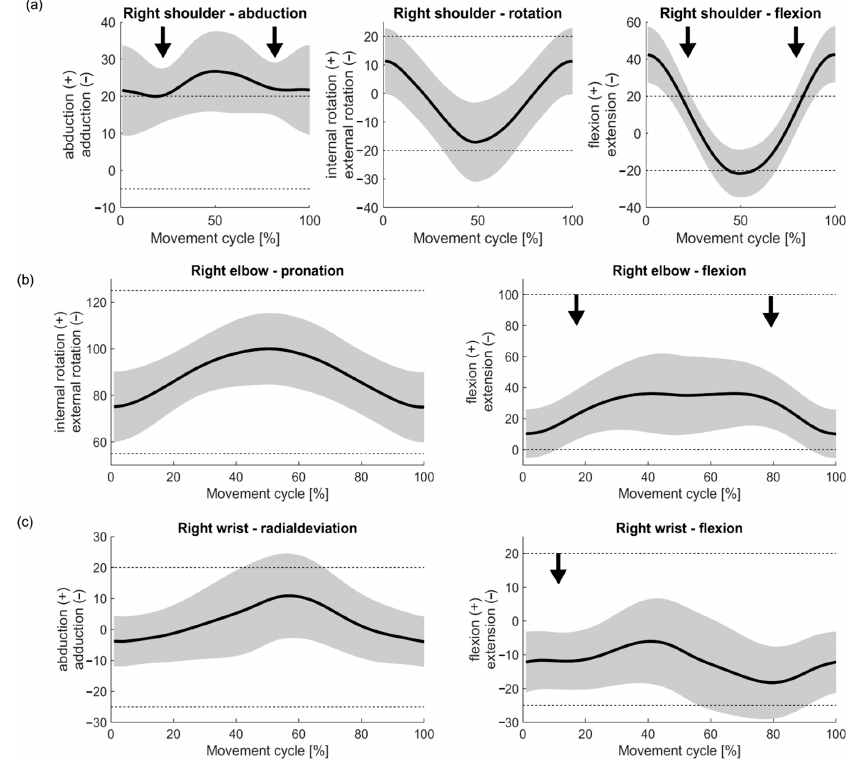
Figure 4. Movements of the right shoulder ( a ), elbow ( b ) and wrist ( c ) in the habitual vacuuming cycle (mean—solid line and standard deviation—grey area). The time dependent angles were time normalized to a full movement cycle. The dashed lines are the lower and upper limits for neutral movements. Movements within the neutral zone are considered ergonomically [21] . The black arrows point to time points of minimal standard deviation. Table 2. Mean values and standard deviations of movements of the right shoulder, elbow and wrist over the course of the cycle. Mean ± SD at Mean ± SD at Cycle Mean of SD Mid-Cycle Start/End (Distal ± SD (Over Joints Dimensions (Proximal Turning Point) in the Cycle) in Turning Point) in Degree (°) Degree (°) Degree (°)